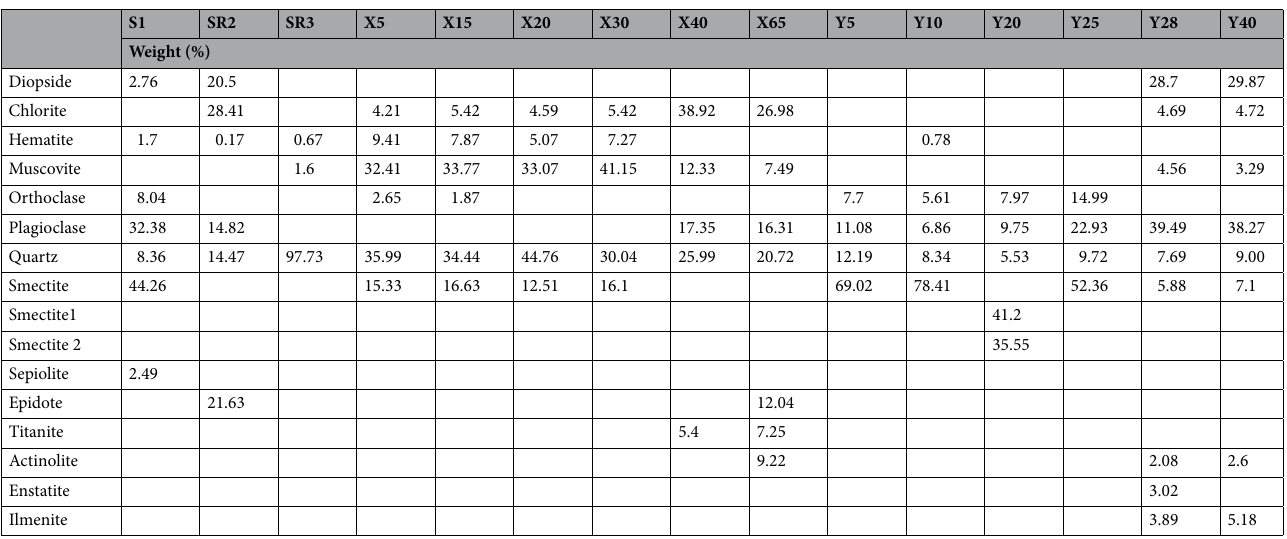
Table 5. Mineral constituents and percentage weight of rocks and soils. S surface soil, SR surface rock, X borehole BH1 depth, Y borehole BH2